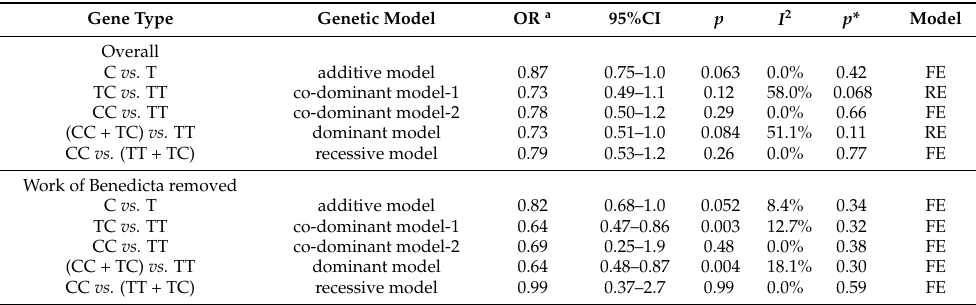
Table 5. Meta-analysis of T1766C polymorphism and EH.